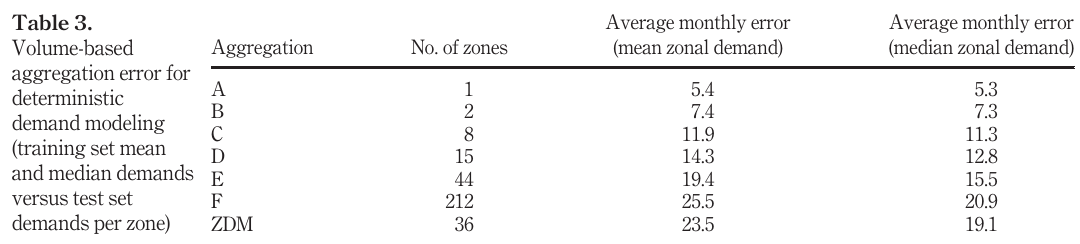
Average monthly error (mean zonal